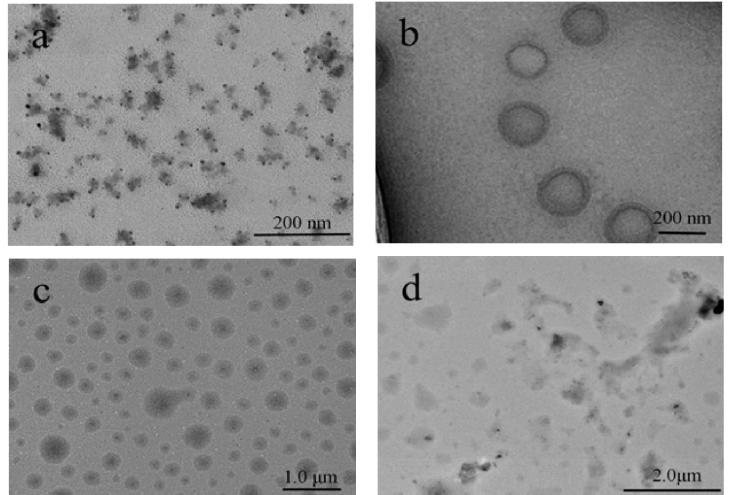
Figure 4. TEM images of PCL- b -PAA aggregates (c = 1.4 mg mL − 1 ) in different environment: ( a ) Blank PMs at neutral environment; ( b ) blank PMs at weakly acid environment; ( c ) GNA-loaded PMs at neutral environment; and ( d ) GNA-loaded PMs at weakly acid environment.